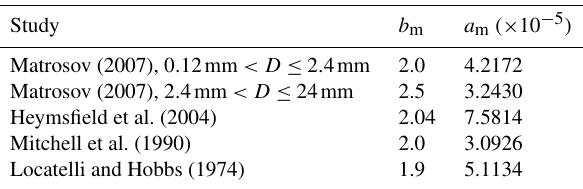
Figure 12. Derived m – D relations assuming exponential PSD in comparison relations presented in literature are shown in Table 3. A conversion of maximum dimension to volume equivalent diameter is done by assuming axis ratio of 0.6. Table 3. The prefactors and exponents of m = a m D b m of literature values for comparison plotted in Fig. 12. A conversion from maxi- mum dimension to volume equivalent diameter is done by assuming axis ratio of 0.6.